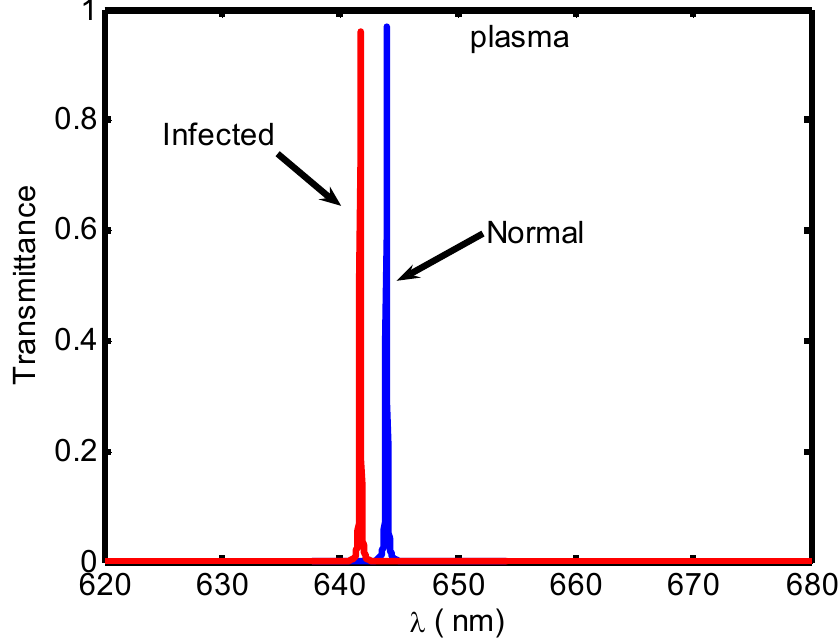
Figure 4. The transmission spectra showing two defect modes inside the PBG of the proposed 1D biophotonic sensor loaded with normal and infected samples containing the plasma component of blood, having a cavity thickness 200 nm at normal incidence.